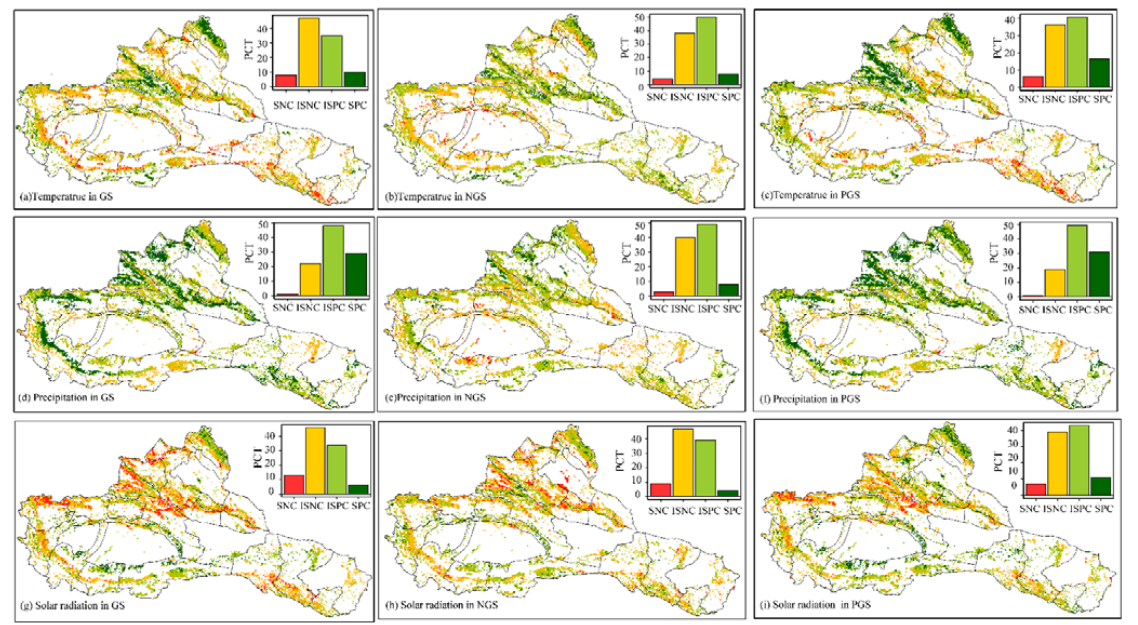
Figure 5. Spatial distribution of correlation coefficients between detrend Normalized Difference Vegetation Index (NDVI) and detrend climate variables at pixels in the arid region of northwestern China (( a , d , g ): correlations between NDVI and temperature, precipitation, and solar radiation during the growing season (GS), respectively; ( b , e , h ): correlations between GS NDVI and temperature, precipitation, and solar radiation of the previous NGS, respectively; ( c , f , i ): Partial correlation between NDVI and temperature, precipitation, and solar radiation during the GS, respectively).